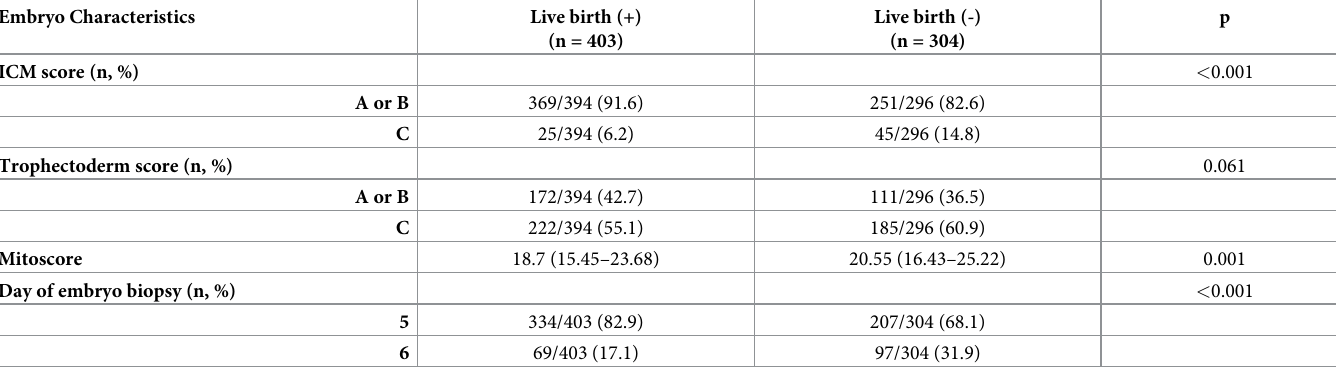
Table 3. Euploid hatching embryo characteristics of patients with or without a live birth. Embryo Characteristics